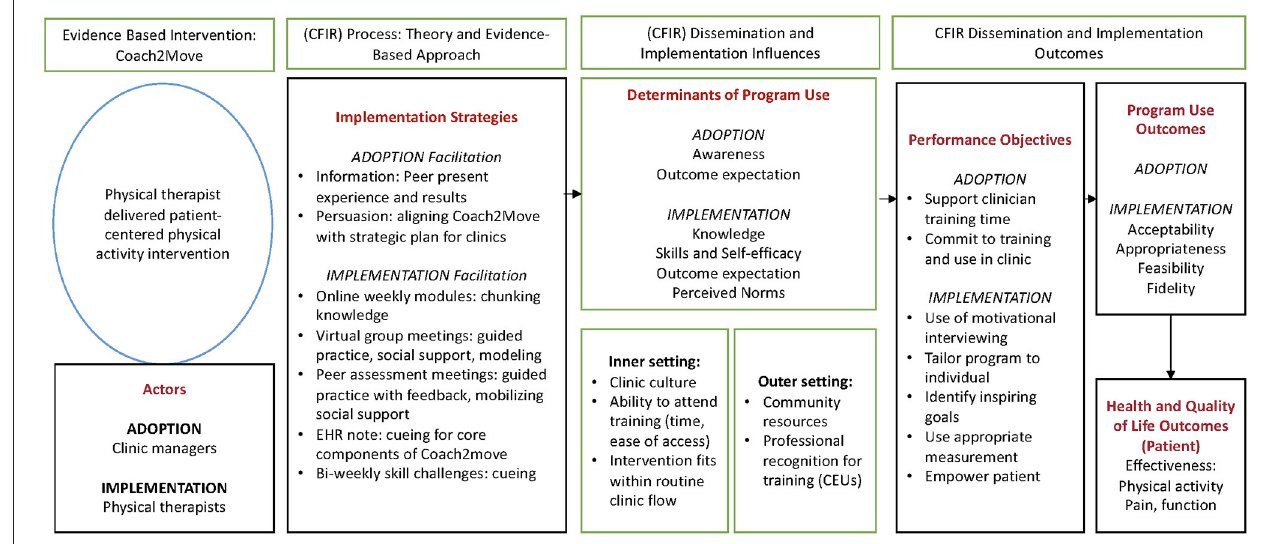
FIGURE 1 | Implementation logic model for Coach2Move guided by intervention mapping and the Consolidated Framework for Implementation Research (CFIR).